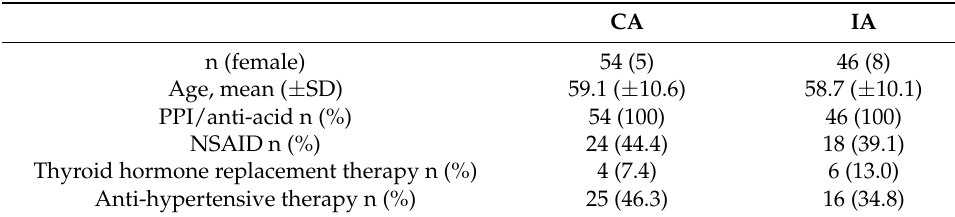
Table 1. Characteristics of the